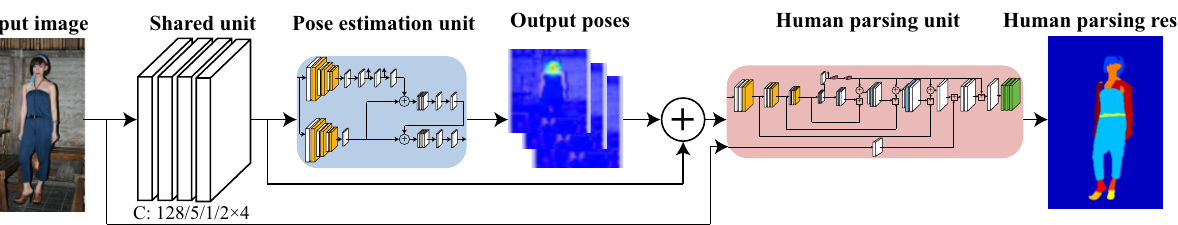
Fig. 1 Network model. Given an input image, image features are extracted in the shared unit. Human pose is estimated as joint-wise heatmaps in the pose estimation unit. Outputs of the shared and pose estimation units are concatenated. The human-image parsing unit outputs a labeled result using the concatenated features. (More detail is given in the Electronic Supplementary Material